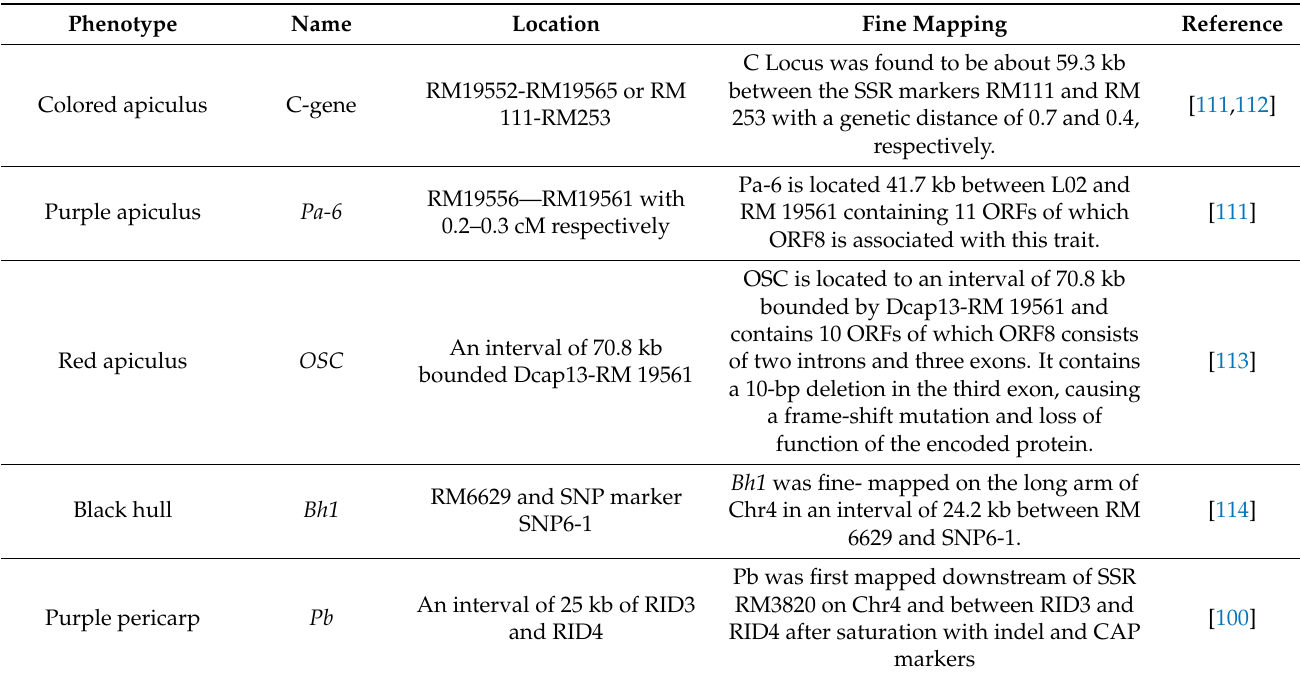
Table 7. QTL associated with various phenotypes responsible for anthocyanin in